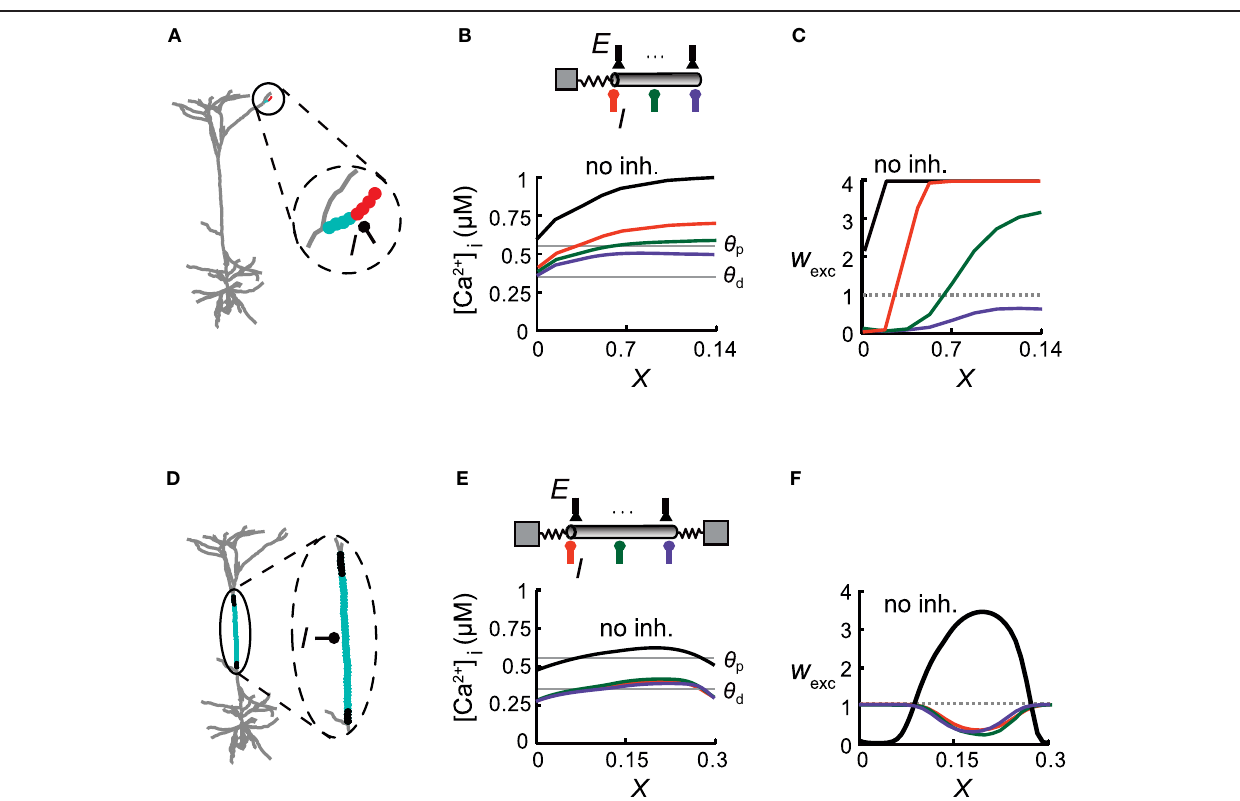
FIGURE 3 | Inhibitory impact on excitatory plasticity depends on the dendritic morphology. (A) Model of a reconstructed L5 pyramidal cell. Inhibition was activated with a conductance of g inh = 1nS in the middle of a distal apical dendritic tuft branch and multiple excitatory inputs were distributed uniformly on this branch (enlarged in circle) and activated at 10Hz. Excitatory synapses near the bifurcation were depressed (cyan circles), whereas more distal synapses were potentiated (red). (B) Top: A simplified model emulating the encircled distal branch in (A) Excitatory synapses ( E ) were evenly distributed in this modeled branch and inhibitory input ( I ) was placed at either X = 0 (orange), X = 0 . 07 (green), or X = 0 . 14 (purple). Bottom: [Ca 2 + ] i versus electrical distance from the bifurcation point for the case without inhibition (black) and with inhibition at the three locations depicted at the top. The thresholds for